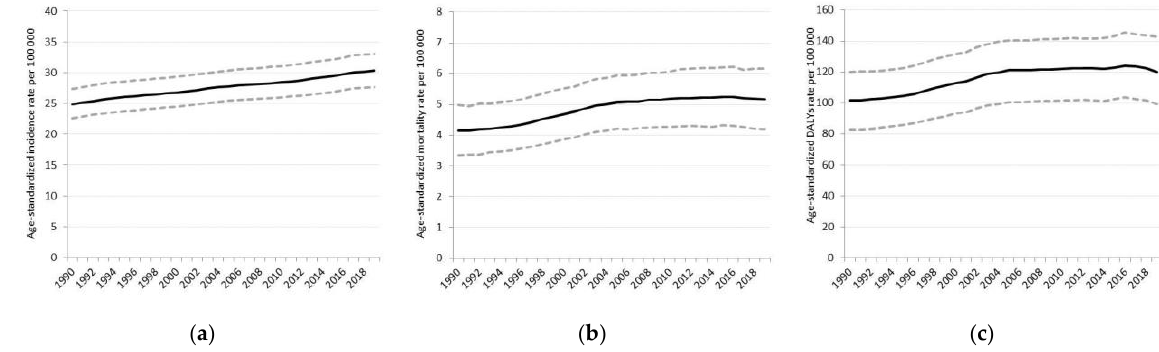
Figure 1. Time trends in ( a ) age-standardized incidence rates, ( b ) age-standardized mortality rates, and ( c ) age-standardized DALYs rates of CKD from 1990–2019. Dashed lines show the 95% uncertainty intervals.